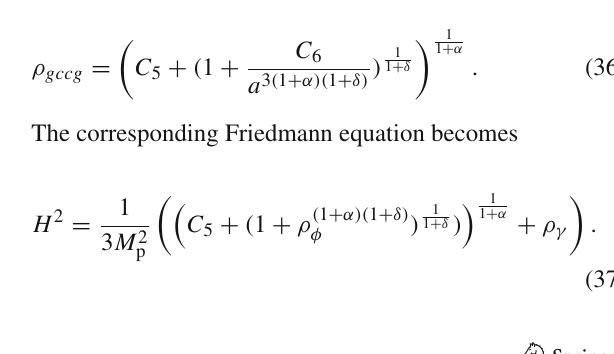
Fig. 11 Plot of r versus n s for MCG model in weak (left panel) and strong (right panel) dissipative regimes for negative potential with n = −